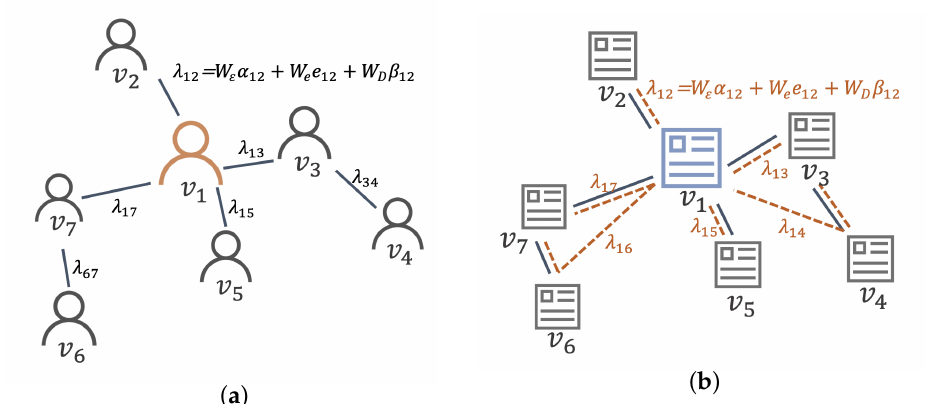
Figure 1. ( a ) Scholar cooperation network. ( b ) Citation network.